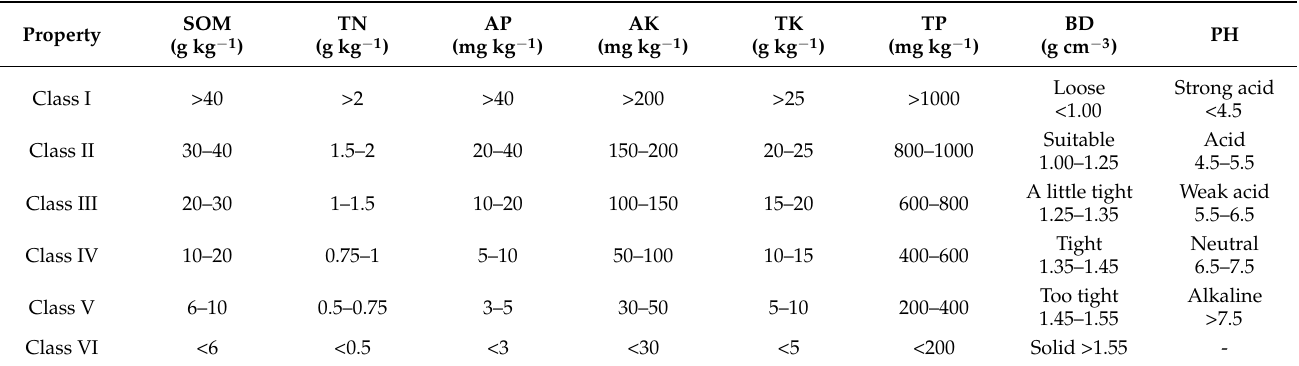
Table 2. The classification standards for some soil properties based on the second national soil census of China and other previous studies.